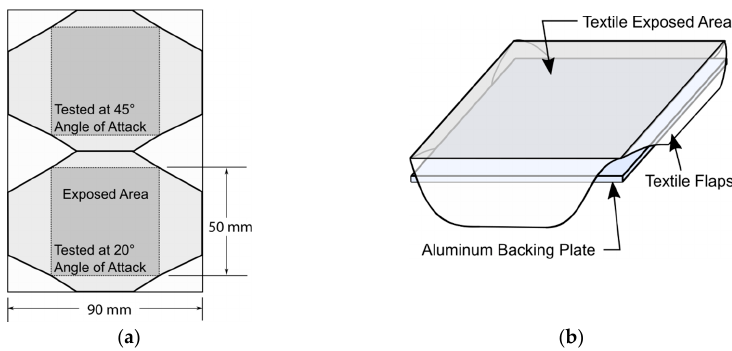
Figure A1. Preparation of fabrics for the flat plate configuration. ( a ) The exposed portion of fabric tested with respect to its original size; ( b ) Placement of the fabric on a rigid backing plate indicating the folding style of the flaps.